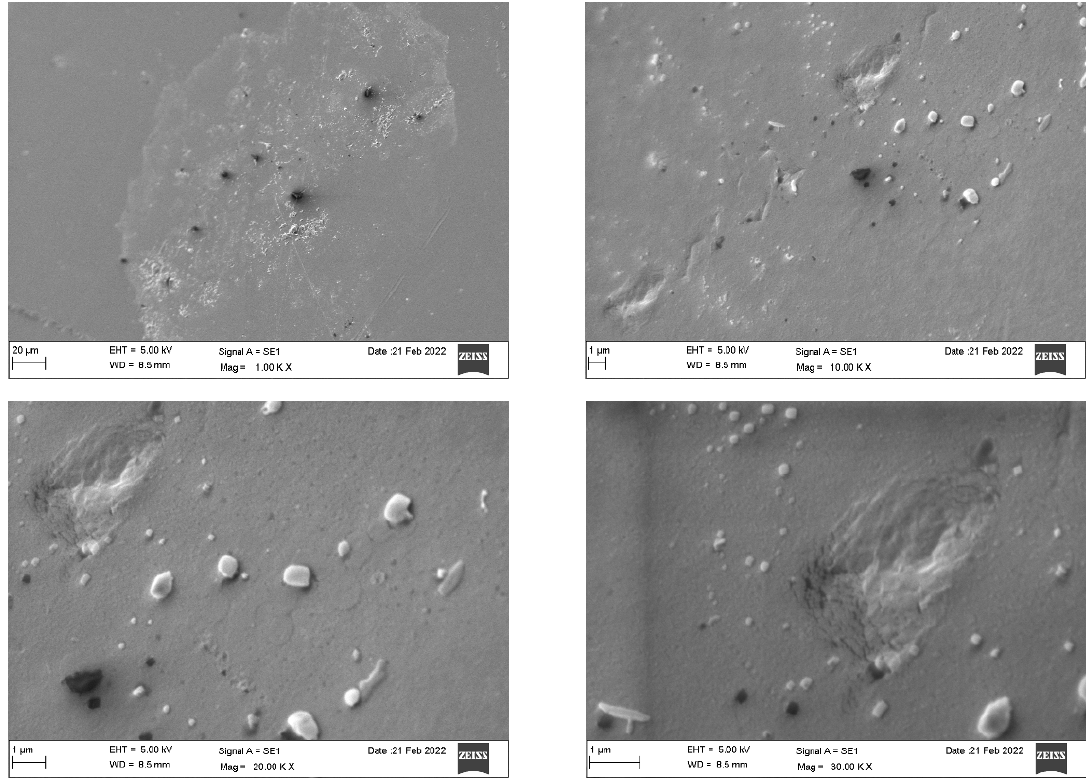
Figure 6. Scanning electron microscopy of the Clarity ® system .